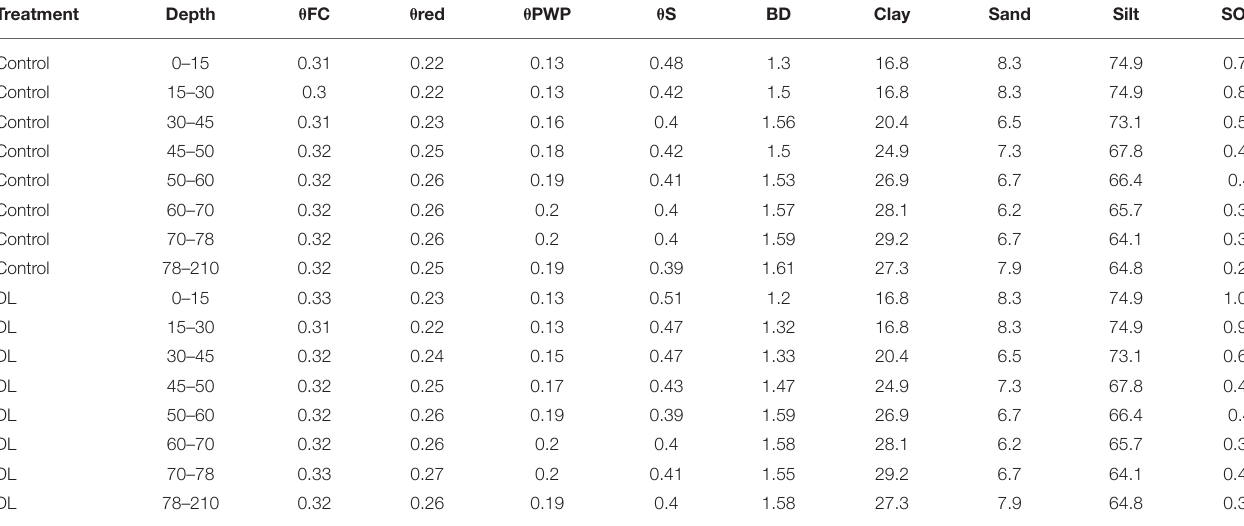
TABLE 1 | Soil properties of the experimental field CF1 (treatments DL and control, mean of CF1-1 to CF1-3) at Campus Klein-Altendorf Research Facility, Rheinbach (University of Bonn, Germany). Treatment